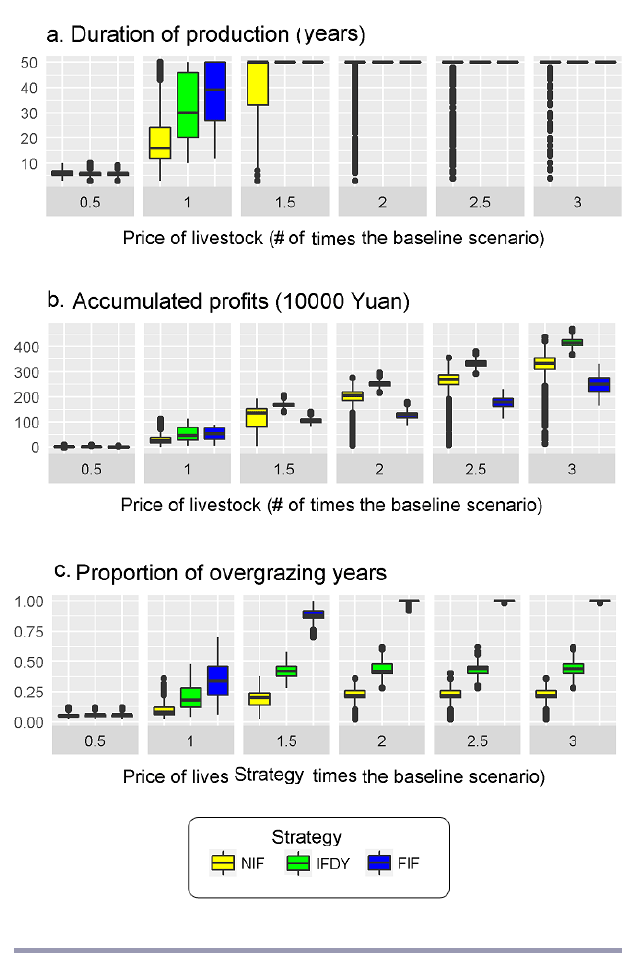
Fig. 5 . The impacts of fodder input on (a) household livelihood, (b) livestock production, and (c) ecosystem health for different livestock price scenarios. Accumulated profits (b) were adjusted based on sheep price level to represent the actual impacts of pastoral production on the increase in value. NIF - no import of fodder, IFDY - import fodder only in disaster years, FIF - frequent import of fodder.